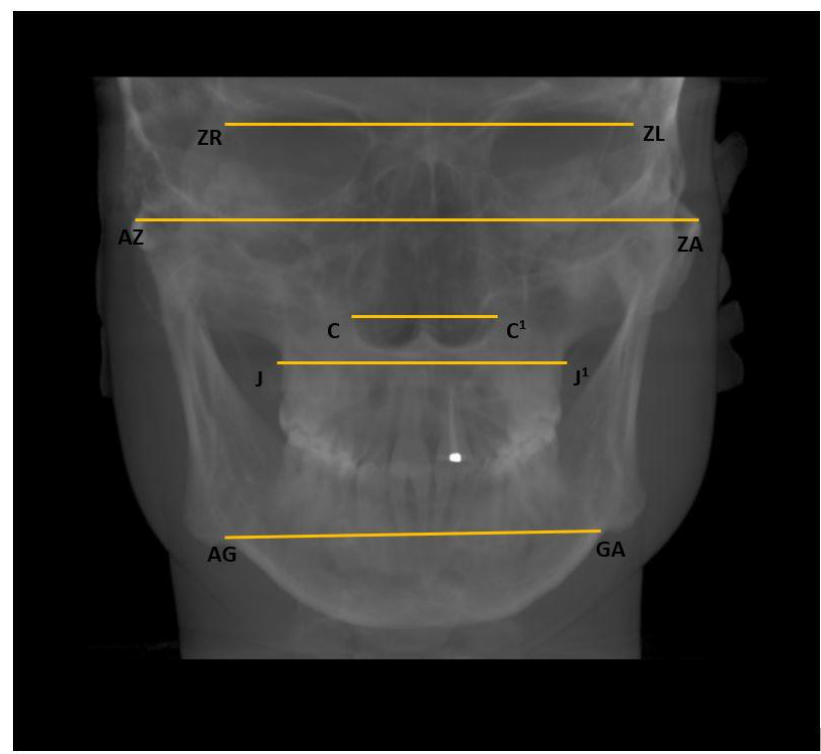
Figure 4. Horizontal measurements of facial asymmetry.